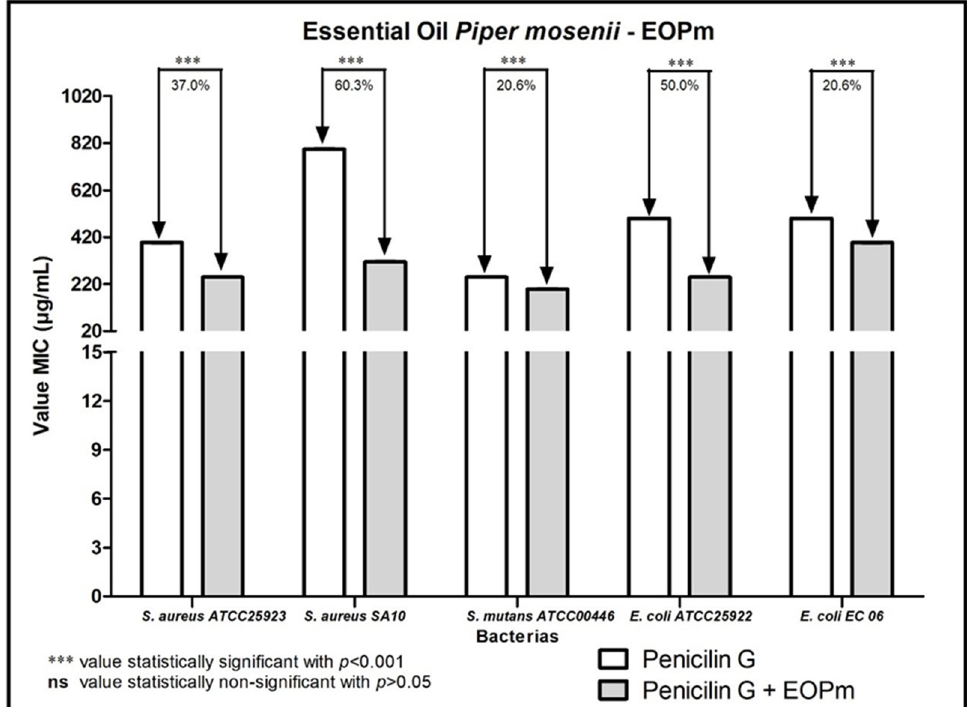
Figure 5. Evaluation of the modulatory activity of EOPm combined with Penicilin G against bacterial strains.